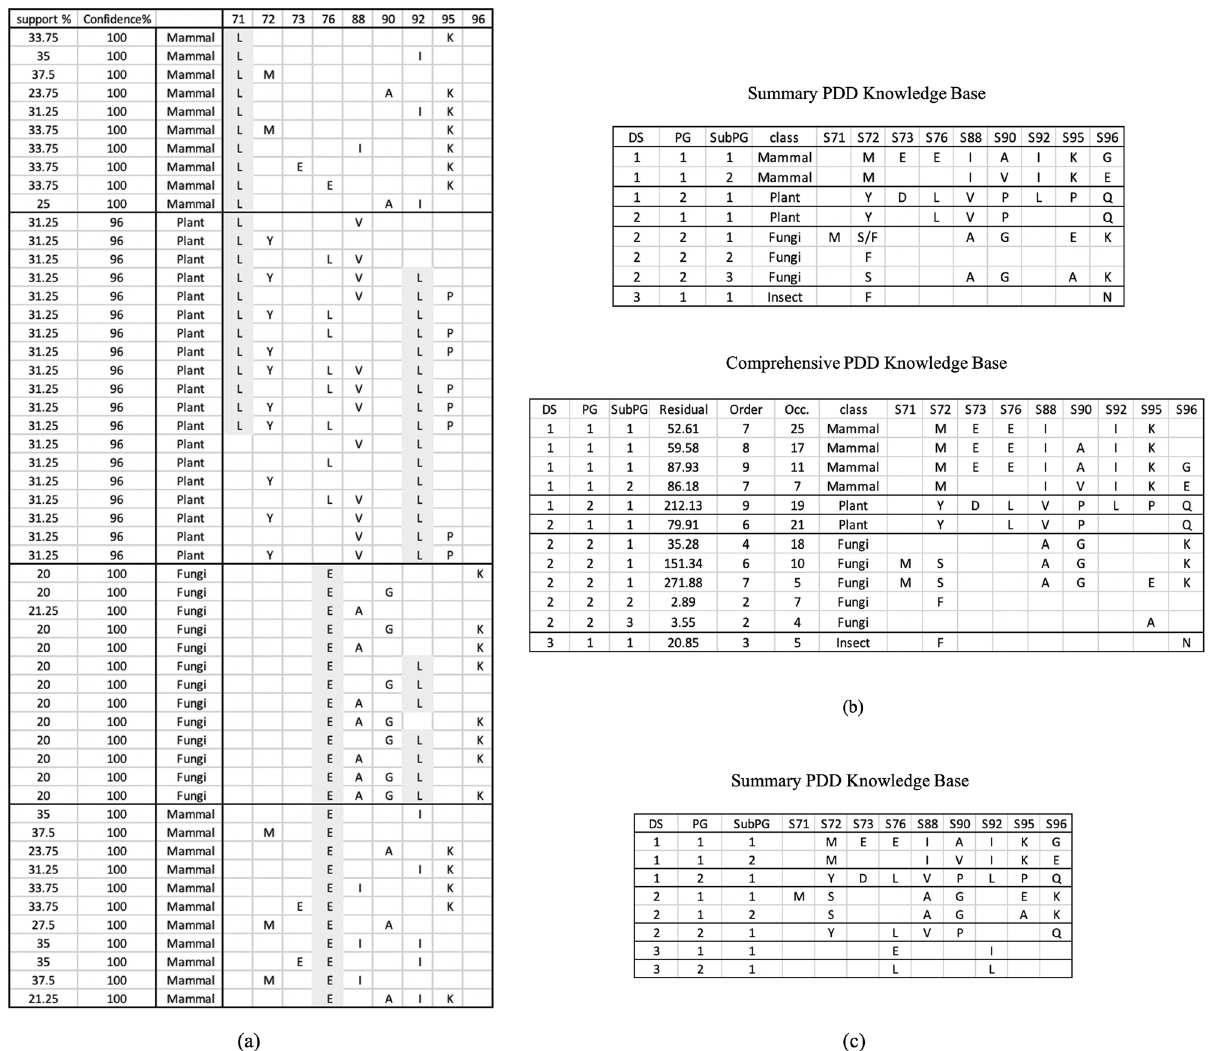
Figure 2. Pattern discovery and disentanglement experiment on an imbalanced APC dataset. ( a ) AVs and patterns discovered by traditional Pattern-Mining Algorithm (Apriori) from different classes are entangled as shown in shaded grey. ( b ) The summarized and comprehensive patterns discovered by PDD reside in distinct DSs associated with distinct taxonomic groups or source environments. The small “Insect” group with pattern [S72 = F, S96 = N] is found in DS3. ( c ) The results of PDD on the same set of data without class labels given produces almost identical results, indicating that PDD does not need prior knowledge to differentiate taxonomic classes in this case (see Supplement